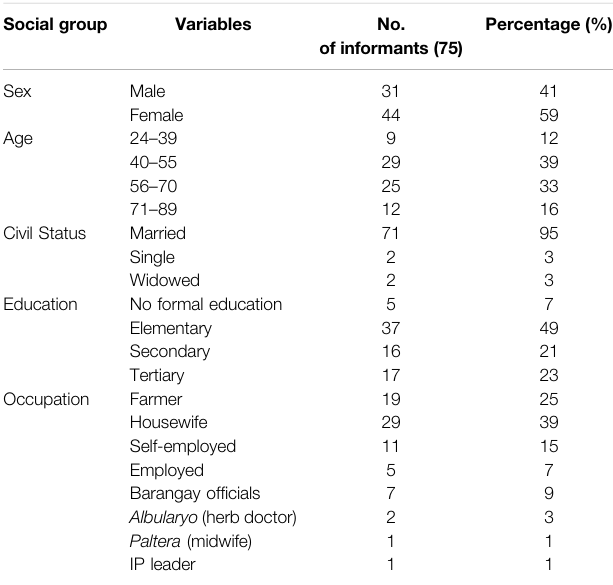
TABLE 1 | Demographic pro fi le of the Panay Bukidnon informants in Lambunao, Iloilo, Philippines. Social group